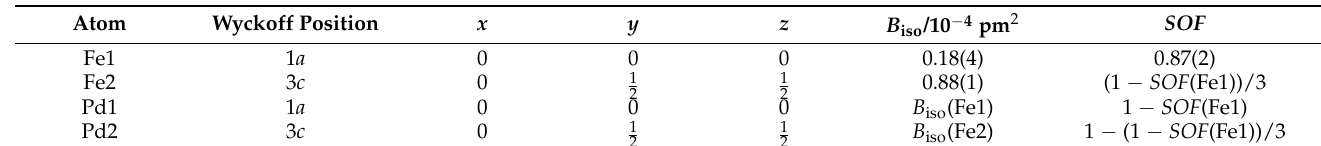
Figure A1. Rietveld refinement of the crystal structure of ordered FePd 3 (AuCu 3 type, Pm 3 (cid:3364) m , a = 385.380(5) pm, R Bragg (pat.1) = 5.45, R Bragg (pat.2) = 49.4; for further details, see Table A1) at 296(1) K based on XRPD powder diffraction data (Co-K α radiation, Smart Lab, R p (pat.1) = 0.105, R p (pat.2) = 0.102, R wp (pat.1) = 0.150, R wp (pat.2) = 0.140, Χ ² = 2.24, background corrected: R ’ p (pat.1) = 0.124, R ’ p (pat.2) = 1.90, R ’ wp (pat.1) = 0.163, R ’ wp (pat.2) = 0.804) using FullProf [24]. Table A1. Crystal structure parameters of FePd 3 ( Pm 3 (cid:3364) m , a = 385.380(5) pm) based on XRPD data (see Figure A1) at 296(1) K.